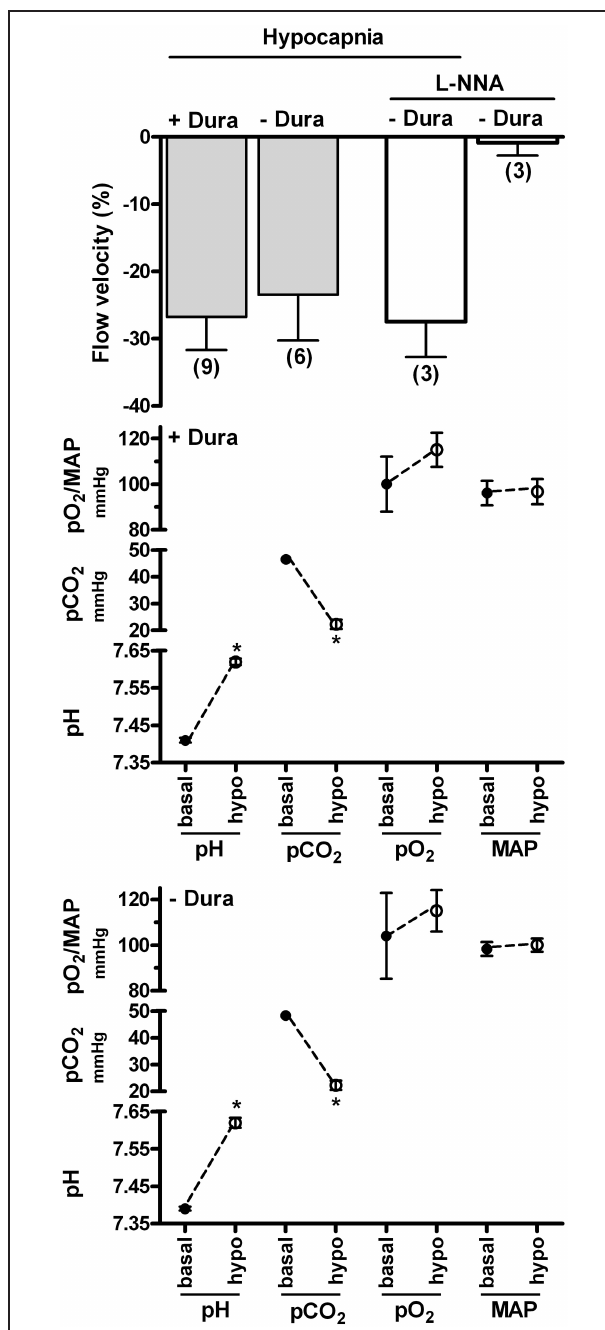
FIGURE 1 | Effects of respiratory hypocapnia in the presence and absence of superfusate and of NO synthase inhibitor on blood flow velocity in rat ventral midbrain. Respiratory rate and/or tidal volume were increased in cranial window preparations superfused with Krebs-Ringer bicarbonate solution ( − Dura) or in preparations with a burr hole in the cranium ( + Dura). Laser-Doppler flow (flow velocity) was calculated as percent baseline (top panel). Arterial blood gas parameters and mean arterial pressure (MAP) are indicated in the lower panels and were similar in preparations with and without dura. Additional superfused preparations were exposed to 0.1mM L-NNA for 30min prior to respiratory hypocapnic challenge.